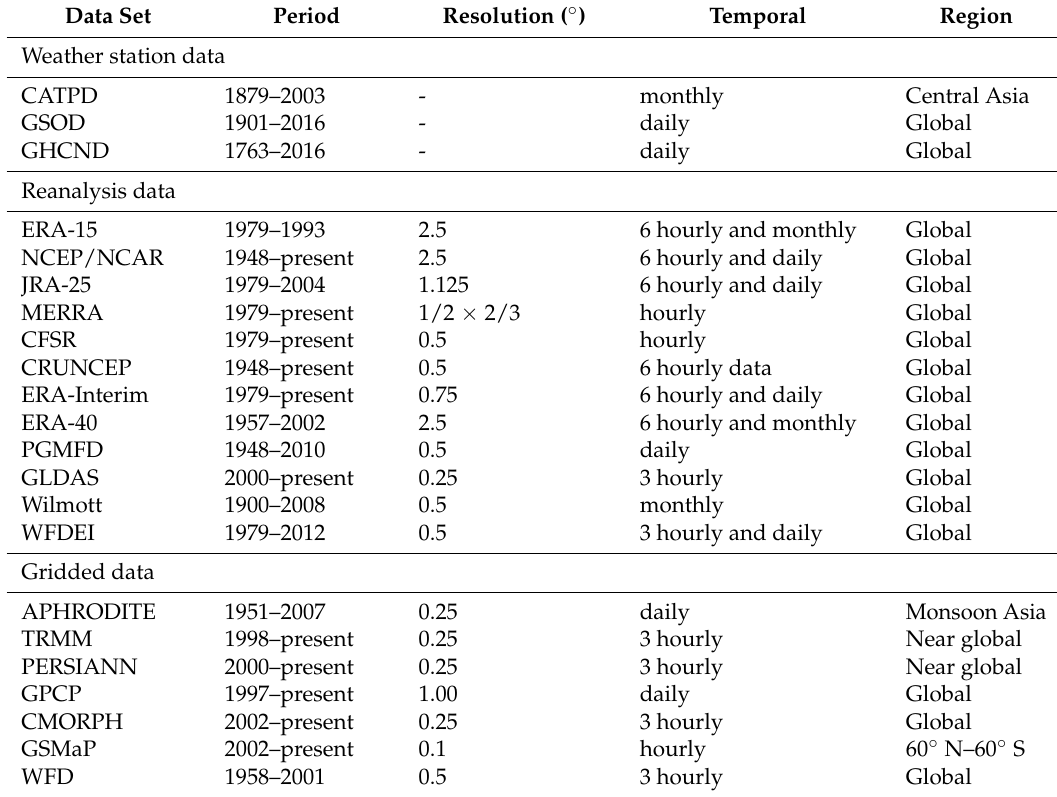
Table 1. Sources of climate